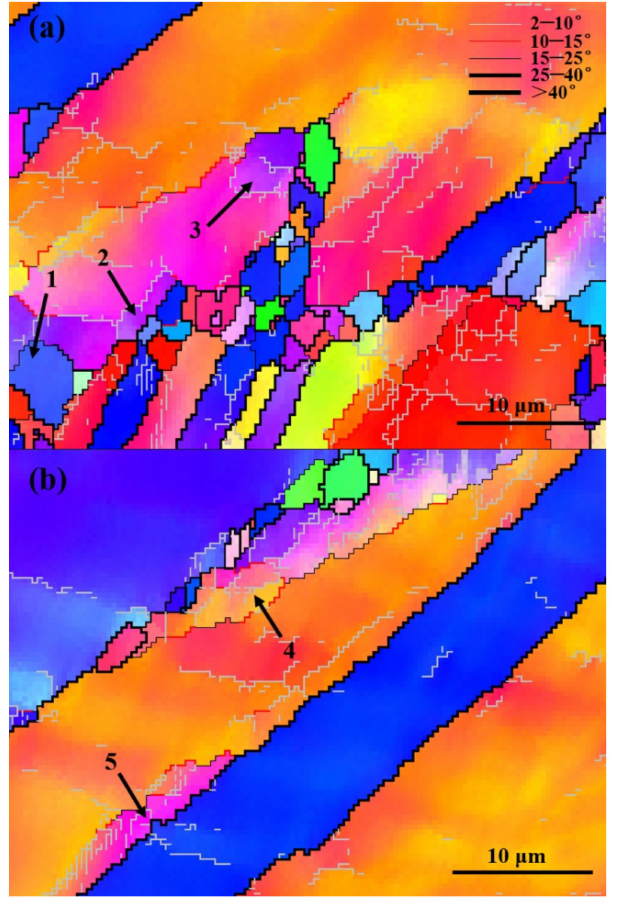
Figure 14. Partial enlarged view of the dotted line in Figure 10: ( a ) the lower part, ( b ) the upper